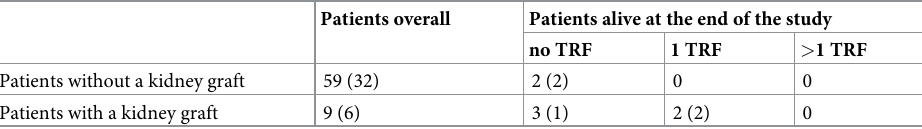
Table 4. Thrombophilic risk factors and surviving patients.